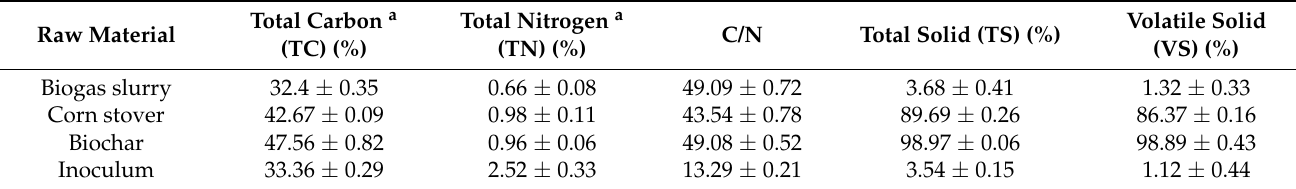
Table 1. Physical characteristics of the raw